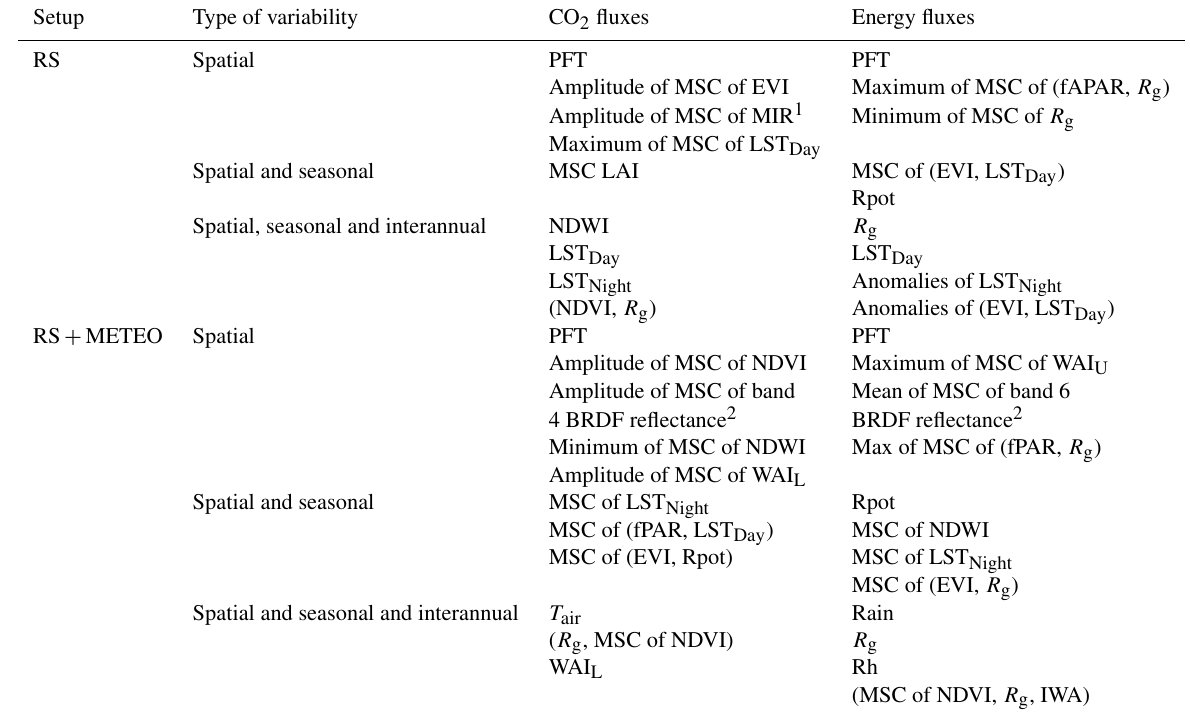
Table 2. Selected predictors for both setups for CO 2 fluxes (GPP, TER and NEE) and energy fluxes ( H , LE and Rn). List of acronyms: Enhanced Vegetation Index (EVI), fraction of absorbed photosynthetically active radiation (fAPAR), leaf area index (LAI), daytime land surface temperature (LST Day ) and nighttime land surface temperature (LST Night ) , middle infrared reflectance (band 7; MIR 1 ) , Normalized Difference Vegetation Index (NDVI), Normalized Difference Water Index (NDWI), plant functional type (PFT), incoming global radiation ( R g ), top of atmosphere potential radiation (Rpot), Index of Water Availability (IWA), relative humidity (Rh), Water Availability Index lower (WAI L ) , and upper (WAI U ) (for details, see Sect. S3), and mean seasonal cycle (MSC). The product between A and B (A × B) is shown as (A,